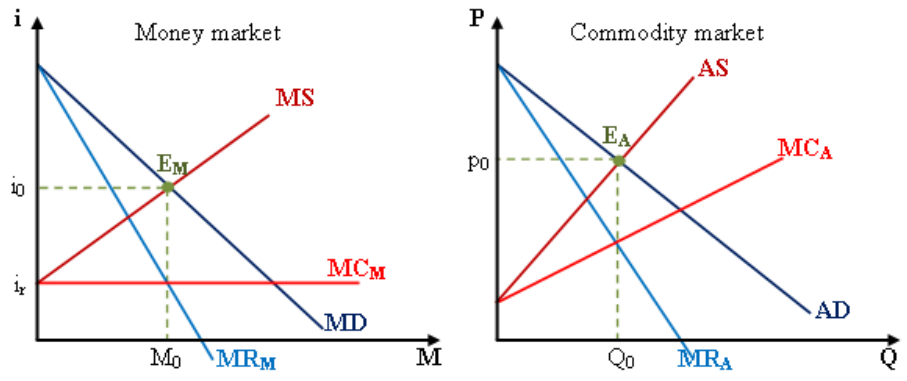
Figure 5. Money market and general equilibrium.